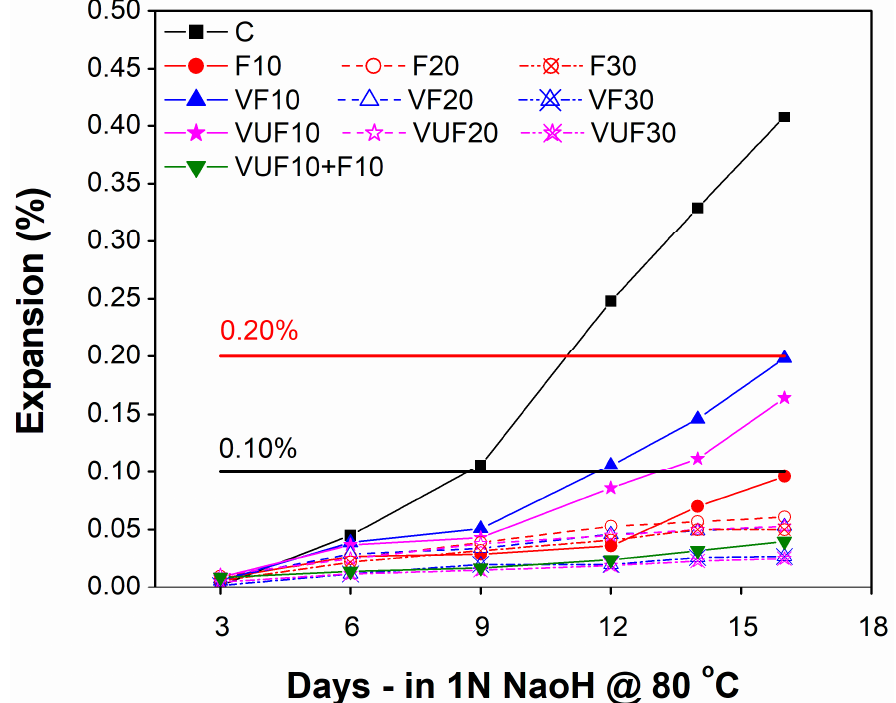
Figure 9. Comparison of ASR expansion between control mortar bar and mortar containing cement, FA, VF and VUF after exposure to accelerated curing conditions.